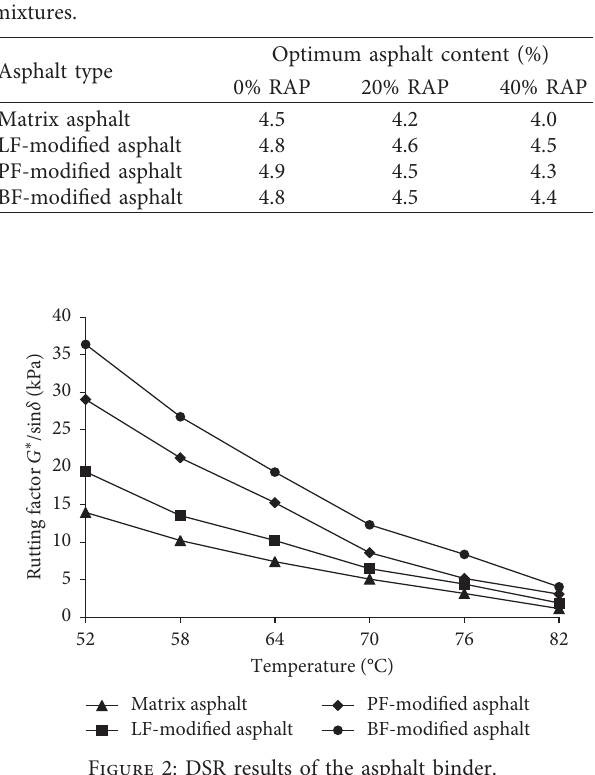
Table 7: Bending creep property of the asphalt